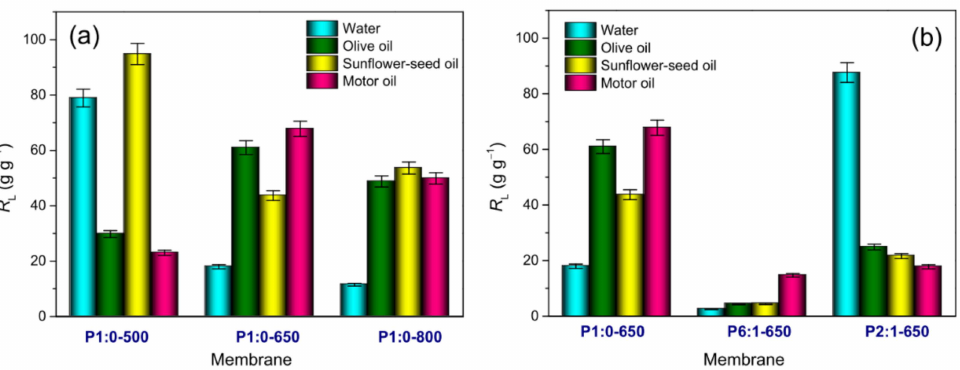
Figure 5. Liquid recovery efficiencies ( R L ) measured in immersion tests: effect of ( a ) the carbonisation temperature of PAN-derived membranes and ( b ) PAN:PMMA mass ratio of PAN/PMMA-derived membranes carbonised at 650 ◦ C. For an easier comparison, in the two plots, the same vertical scale is